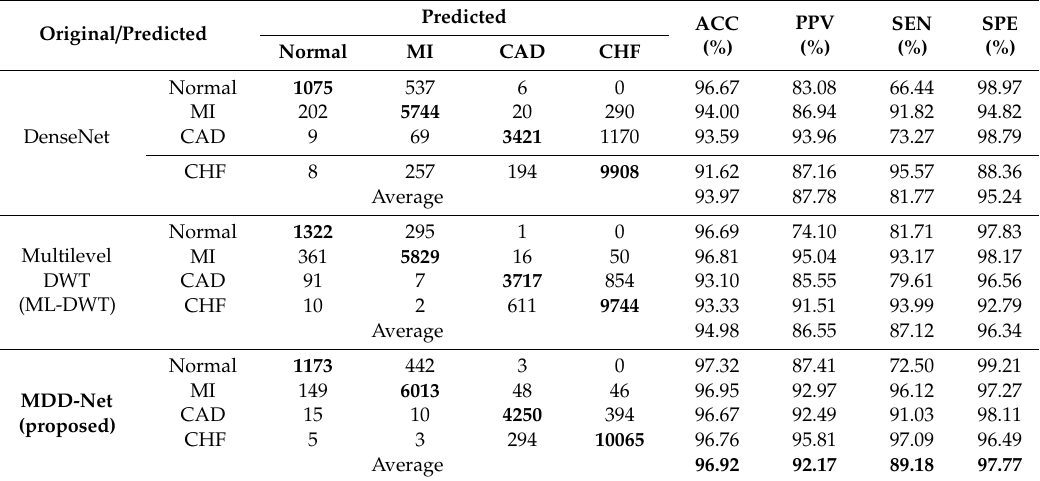
Table 10. The results for cardiovascular detection under inter-patient paradigm.